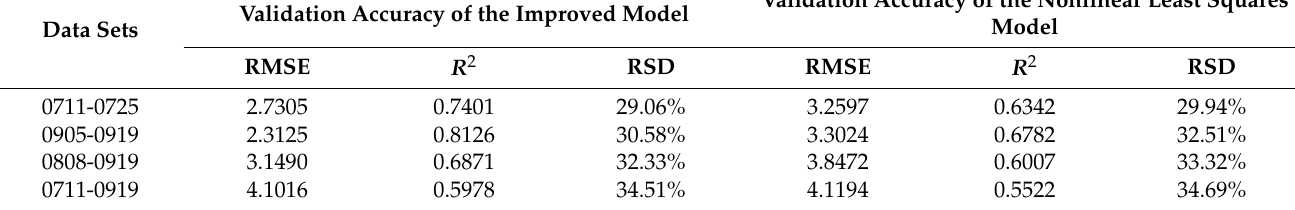
Table 4. The validation accuracy of the four data sets.